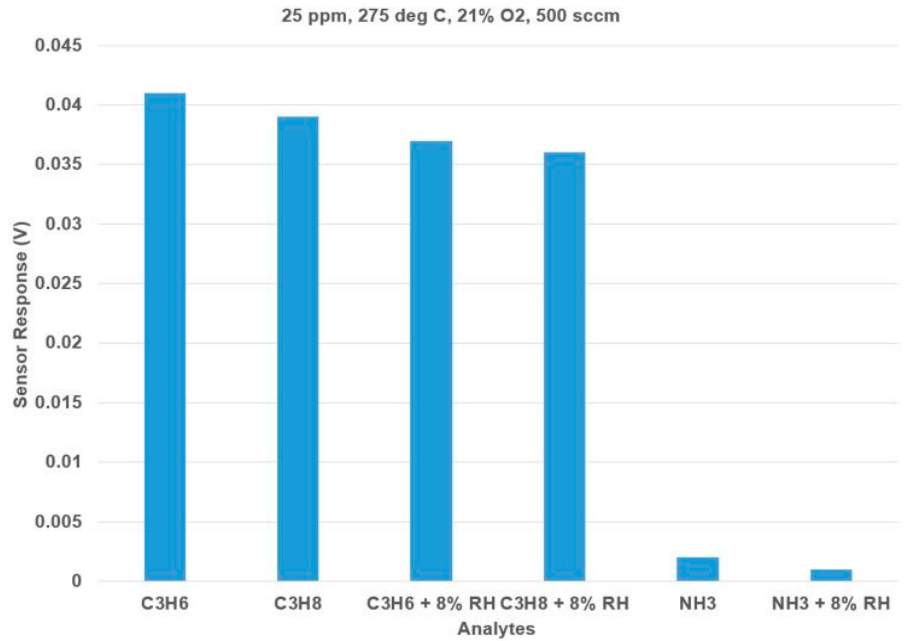
Figure 6. Effect of humidity (8% RH) on the sensor response to Hydrocarbons and Ammonia. The standard deviation after three trials of measurements is 0.002 V.